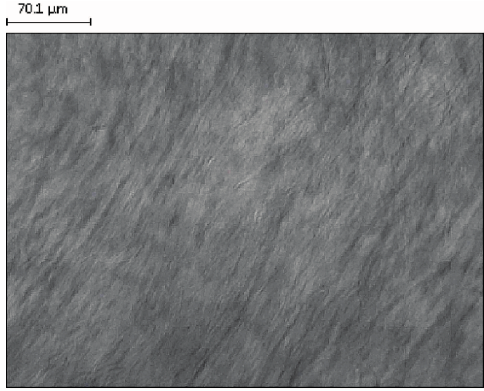
Figure 1. Polarizing microscopic examination of blank lyotropic liquid crystal systems (LLC) at a magnification of